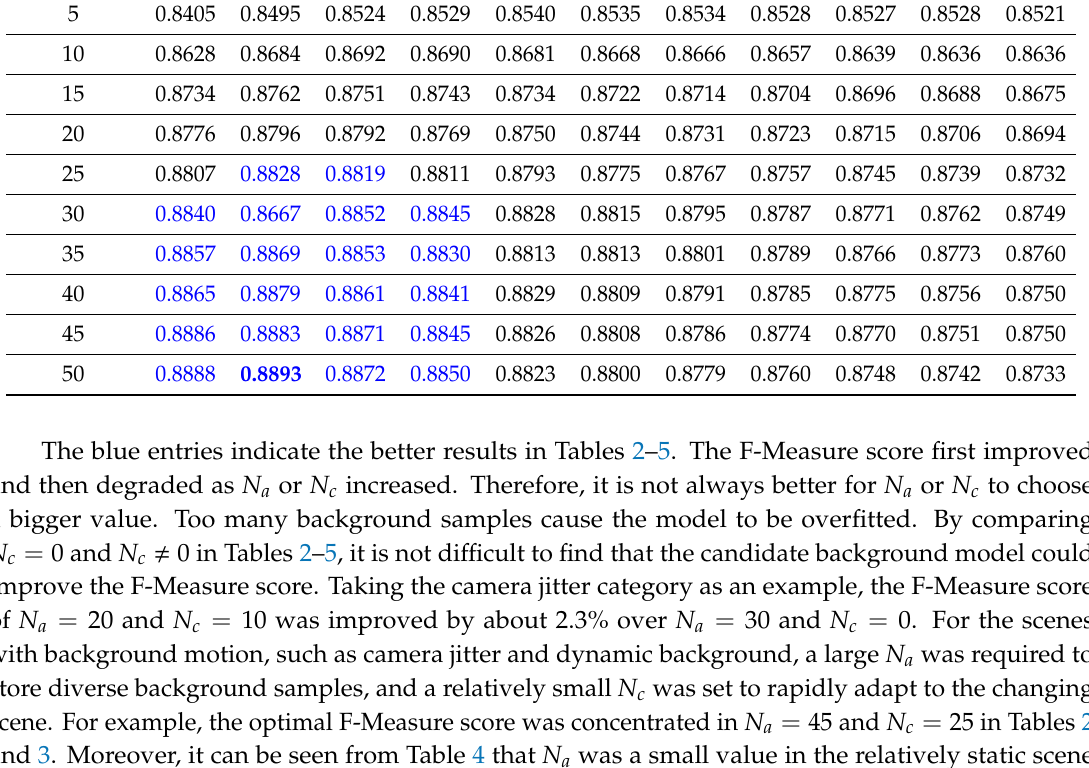
Table 5. Average F-Measure scores obtained on bad weather category using di ff erent N a and N c . N c N a